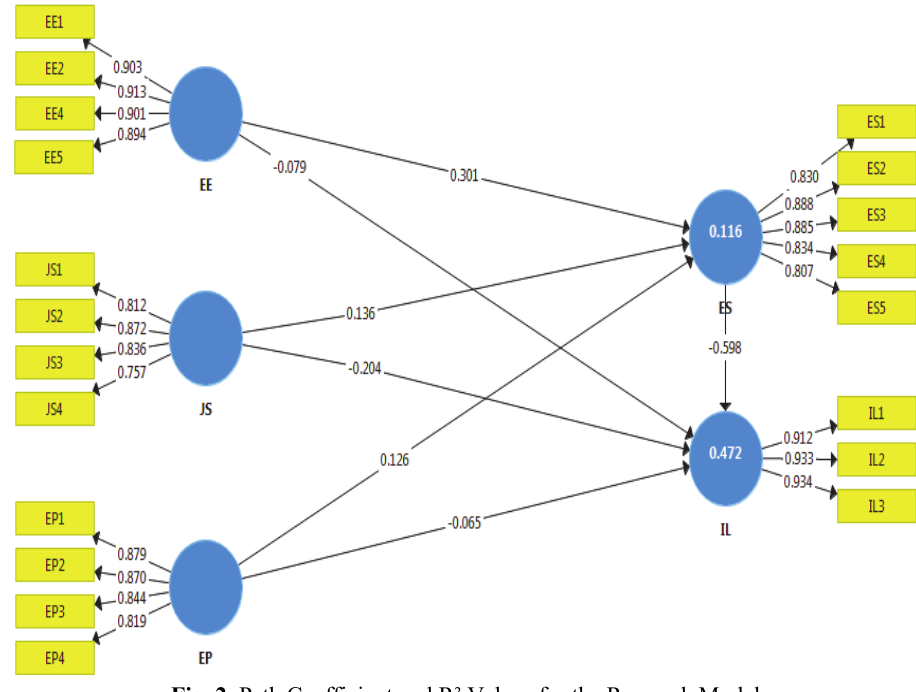
Fig. 2. Path Coefficient and R² Values for the Research